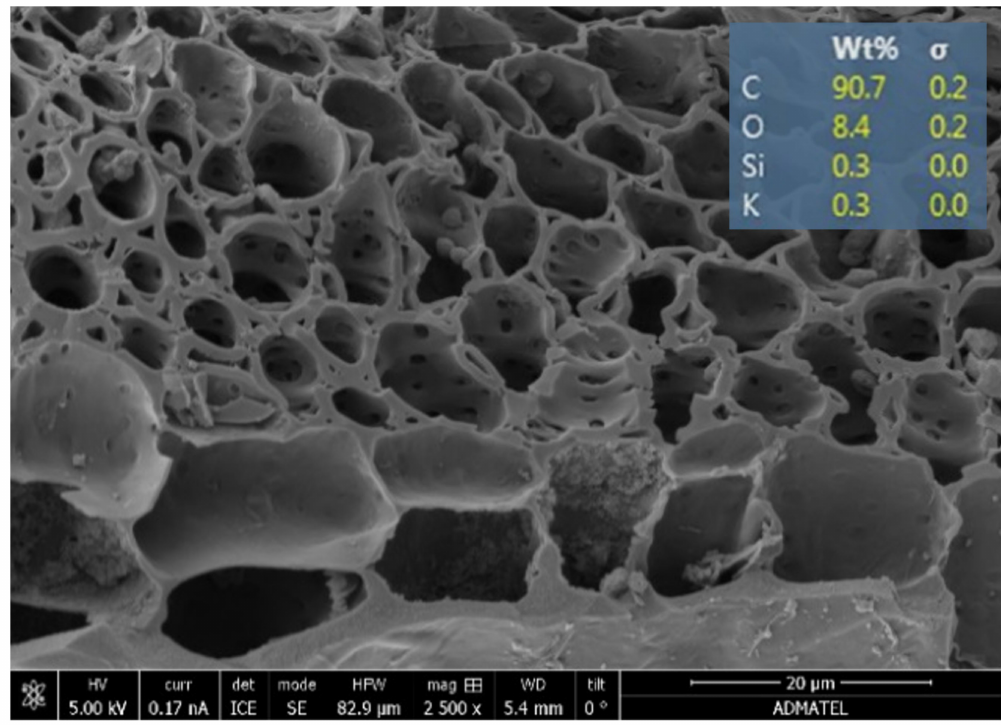
Figure 2. SEM-EDX analysis of biochar at 2500 ×